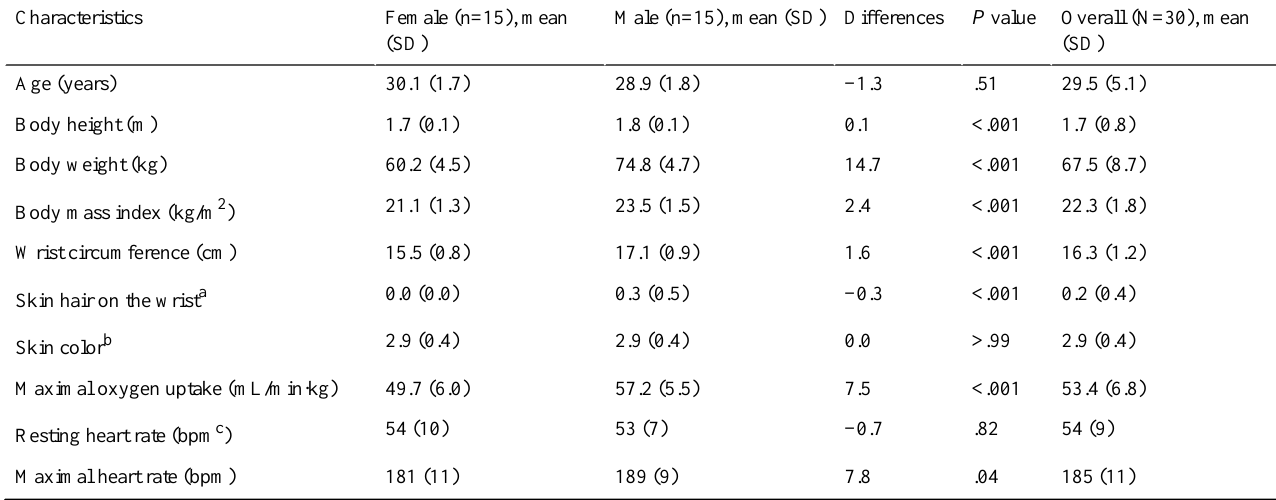
Table 1. Participants’characteristics.